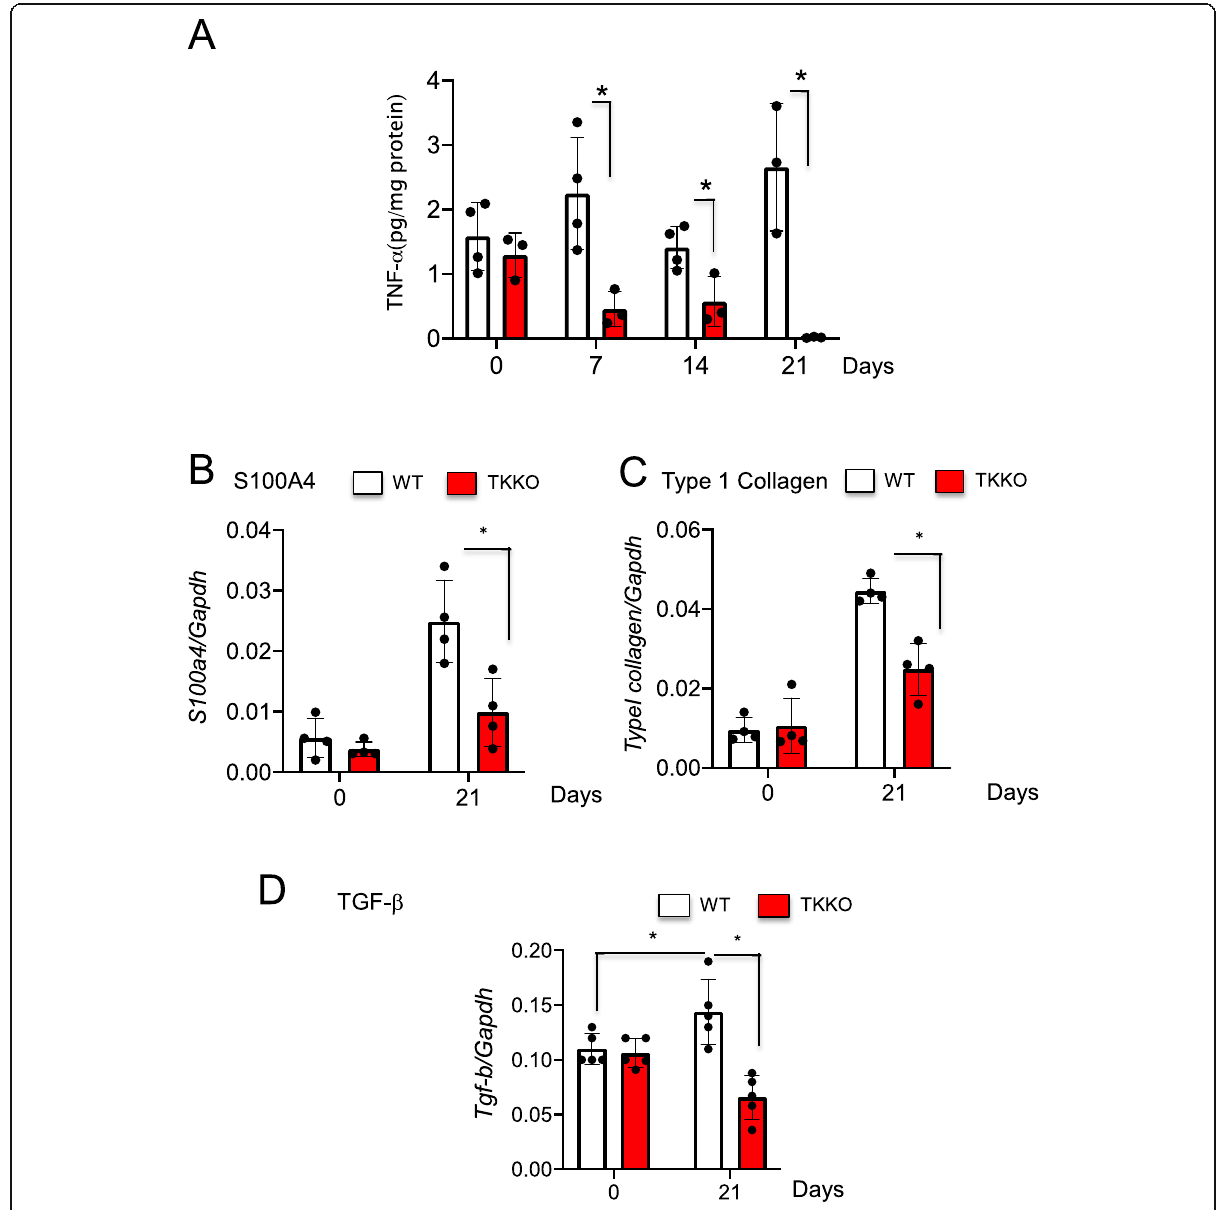
Fig. 3 VEGFR1 TK signaling induces the expression of fibrosis-stimulating factors. a TNF- α levels in the lung after BLM treatment. Data are expressed as the mean ± SD (n = 4 mice per group) *p < 0.05 versus WT mice. b - d Expression of S100A4 ( b ), type I collagen ( c ), and TGF- β ( d ) in the lung on day 21 after BLM treatment. Data are expressed as the mean ± SD (n = 4-5 mice per group). *p < 0.05 versus WT mice